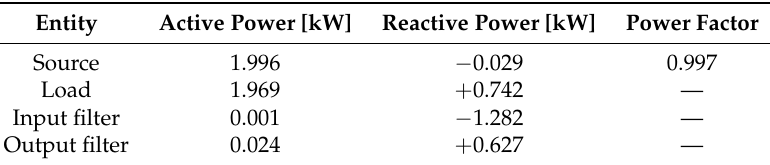
Table 4. Summary of the average power consumption in the matrix converter. The overall efficiency is